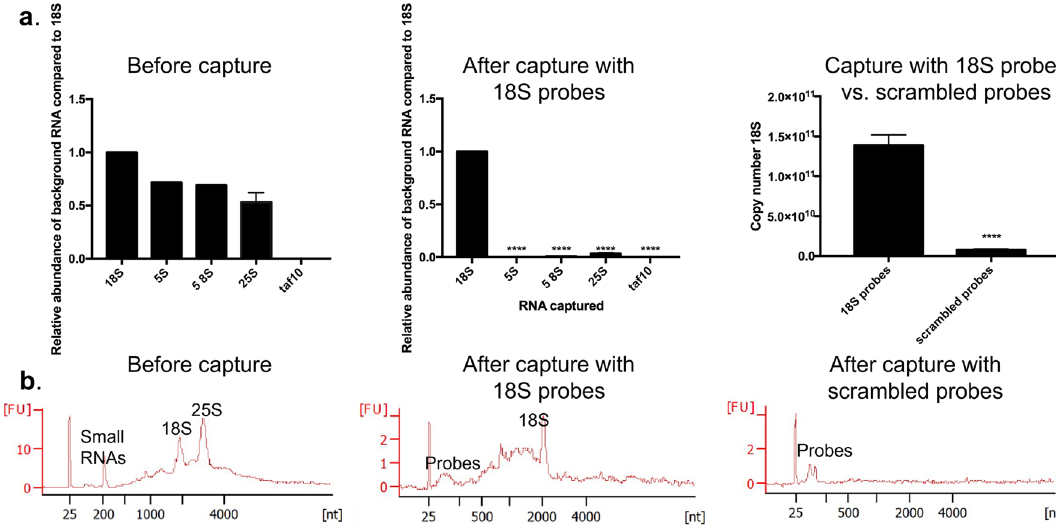
Figure 4. Quality control of 18S rRNA capture ( a ) Quantification of the contamination after capturing 18S. **** represents a two-tailed p-value < 0.0001 (left panel) Relative abundance of 5S rRNA, 5.8S rRNA, 25S rRNA and taf10 compared to 18S rRNA before capture. Values are calculated as the amount of background before capture divided by the amount of 18S before capture. Error bars represent SEM, n = 2. Significance is determined with an unpaired t-test. (middle panel) Relative abundance of 5S rRNA, 5.8S rRNA, 25S rRNA and taf10 compared to 18S rRNA after capture with 18S probes. Values are calculated as the amount of background after capture divided by the amount of 18S after capture. Error bars represent SEM, n = 2. Significance is determined with an unpaired t-test. (right panel) Yield of 18S rRNA comparing captured with 18S probes with capture with scrambled probes. Values are calculated by extrapolation on a standard curve of the plasmid PGEM-T_ fulllength18S. Error bars represent SEM, n = 2. Significance is determined with an unpaired t-test. ( b ) RNA pico BioAnalyzer (Agilent) (left panel) SAPS purification diluted to a concentration within the range of an RNA pico chip (middle panel) Capture with 18S probes (right panel) Capture with scrambled probes. FU values are not relevant, due to different elution volumes used when performing the RNP capture for BioAnalyzer vs. for mass